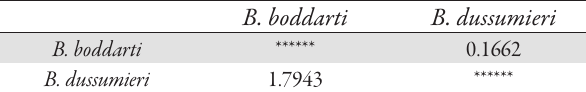
Tab. 3. Nei’s (1978) genetic identity (above diagonal) and